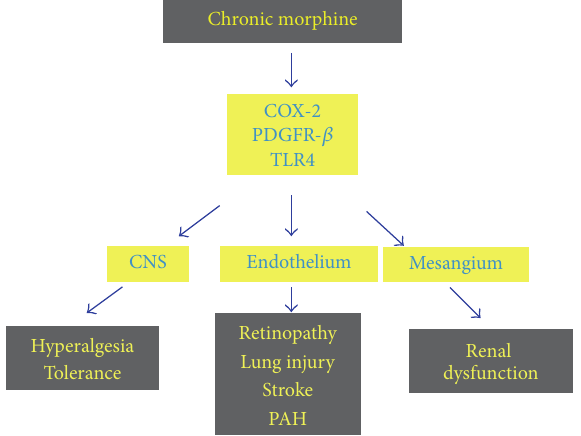
Figure 1: Proposed model of morphine-induced signaling lead- ing to organ damage. Morphine signaling via cyclooxygenase-2 (COX-2), platelet-derived growth factor- 𝛽 (PDGFR- 𝛽 ), and toll-like receptor4(TLR4)mayunderliethemorphine-inducedhyperalgesia and tolerance via its action on the central nervous system (CNS); promote endothelial dysfunction and associated retinopathy, lung injury, pulmonary arterial hypertension, and stroke; and contribute to renal dysfunction in sickle cell